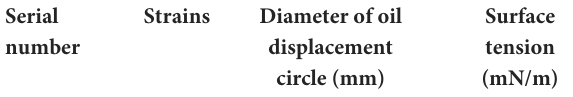
TABLE 2 The microbial strains screened from two environmental samples using the established